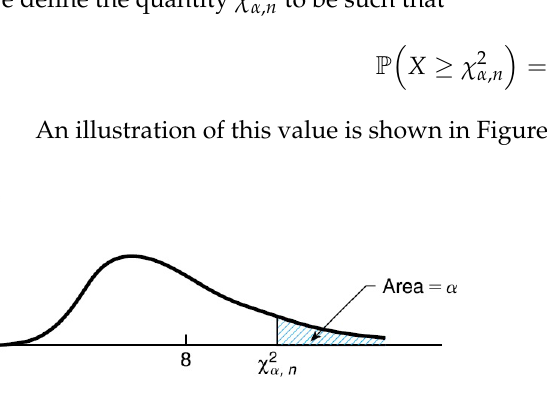
Figure A1. The chi-square density function with eight degrees of freedom.